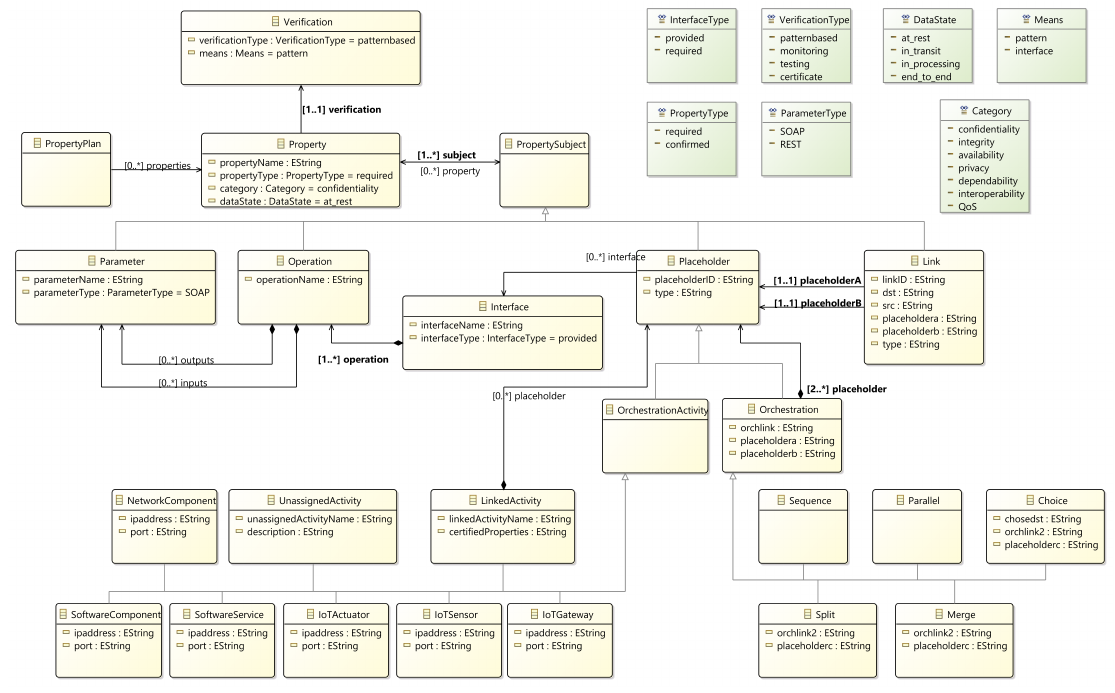
Figure 5. IoT orchestrations system